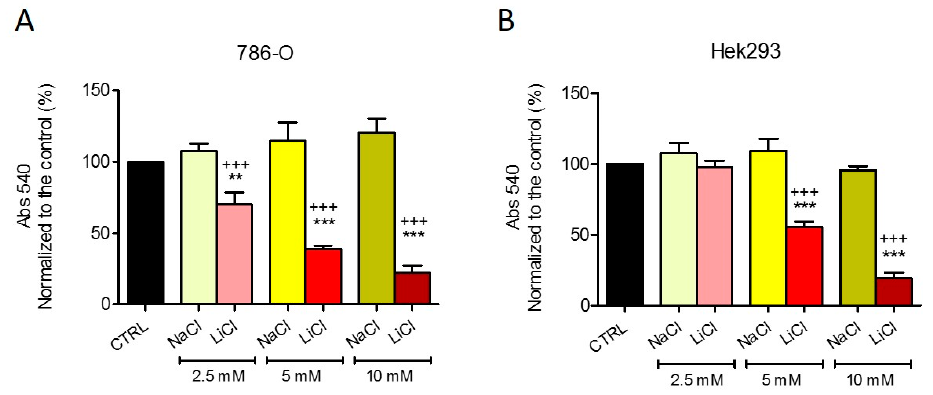
Figure 2. Growth of 786-O ( A ) and HEK293 ( B ) cells treated with 2.5 mM, 5 mM, and 10 mM LiCl or NaCl. Data are given as mean ± SD. Statistical analysis was performed by using one-way ANOVA (Dunnett’s Multiple Comparison Test); treatments vs. control: ** p < 0.01, *** p < 0.001; LiCl vs. equimolar NaCl: +++ p < 0.001; n = 3 independent experiments (6 wells/treatment/experiment).